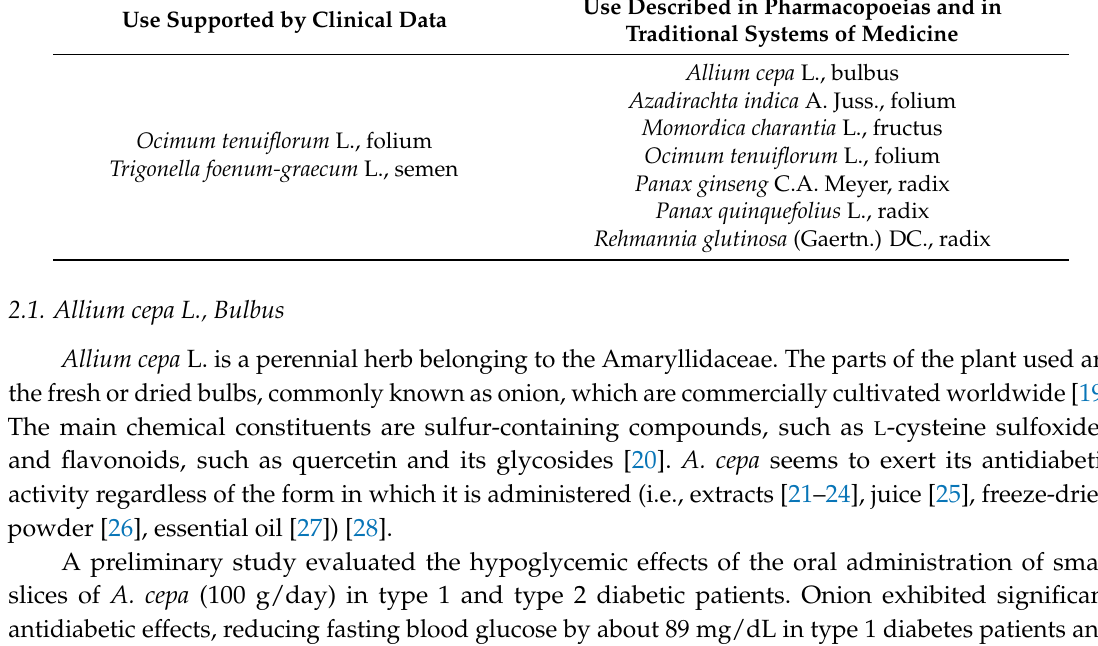
Table 1. Species enlisted in WHO monographs with indication of use for diabetes. Use Supported by Clinical